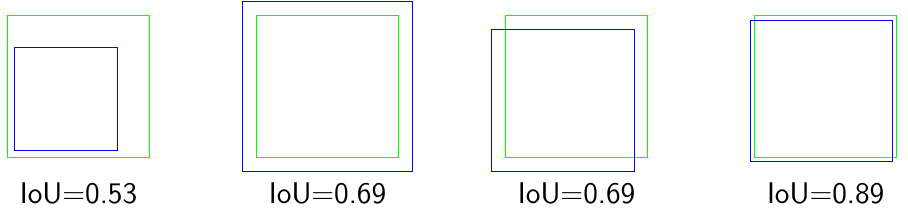
Figure 6. Multiple overlapping configurations and their calculated IoU ratio. In green, the ground-truth bounding box; in blue, different proposals of the bounding